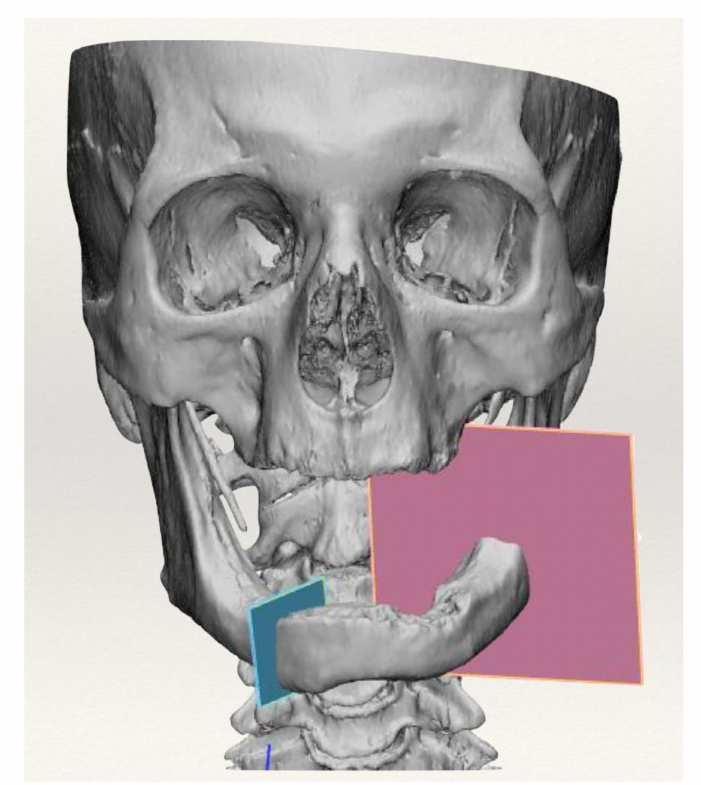
Figure 2. Virtual resection